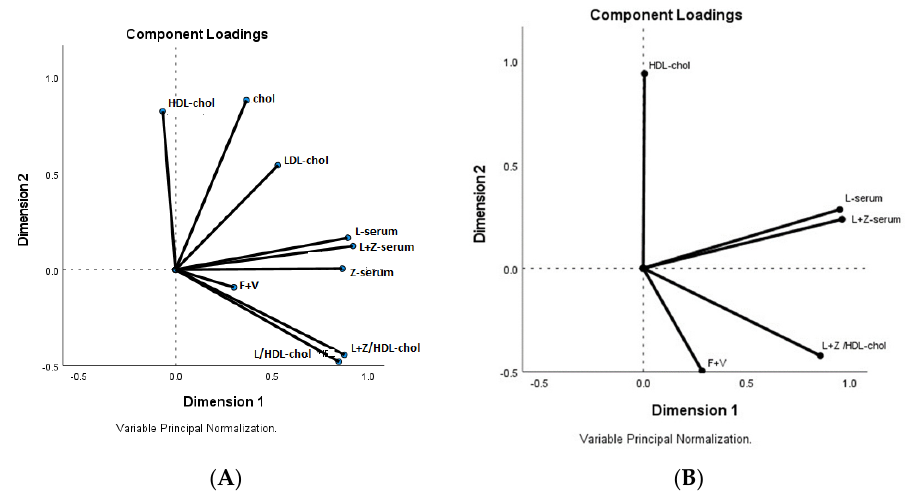
Figure 2. Factor analysis loading plot. Two principal components. ( A ) Serum lutein, fruit and vege- table groups, zeaxanthin and lutein+zeaxanthin, lutein/HDL-cholesterol, lutein+zeaxanthin/HDL-